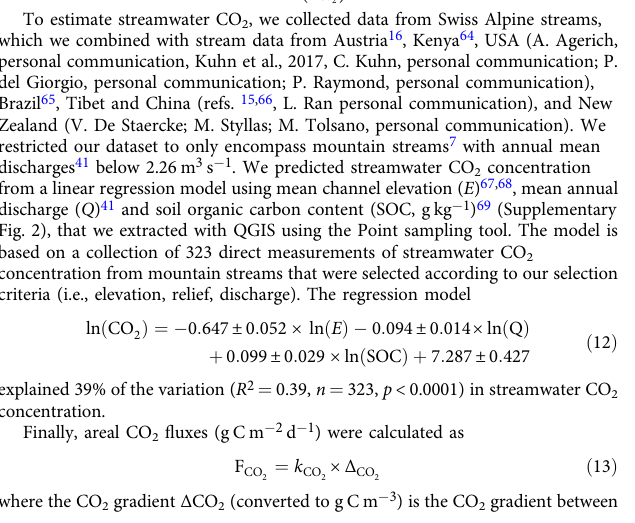
Table 2) and catchment C had a median groundwater p CO 2 of 4267 µatm (CI: 2230 and 6303 µatm, n = 2; Supplementary Table 2). Yet, those few measurements